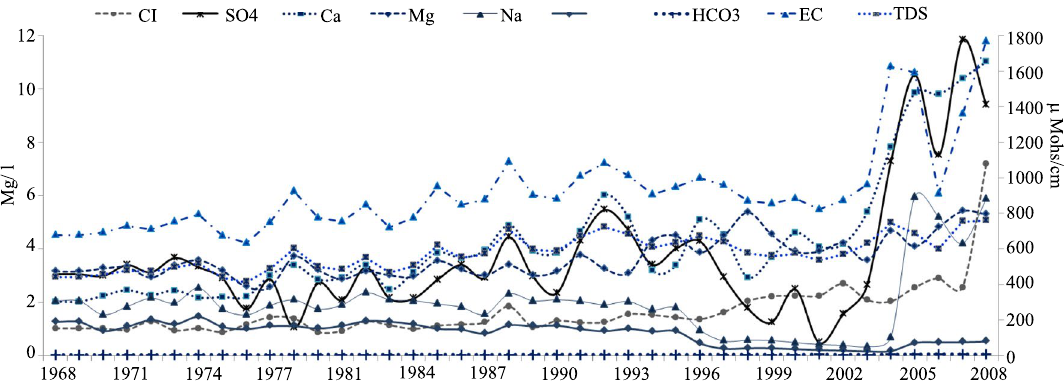
Fig. 11 Time classification of foretold values for the last 5 years of water quality